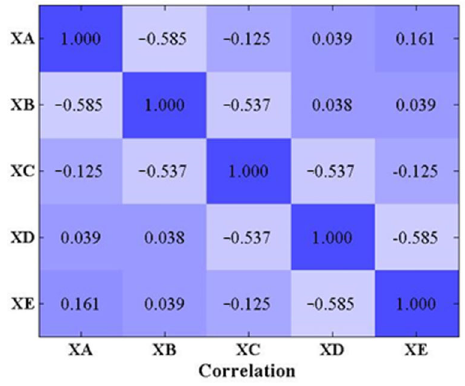
Figure 5. The correlation coefficients between original signals.